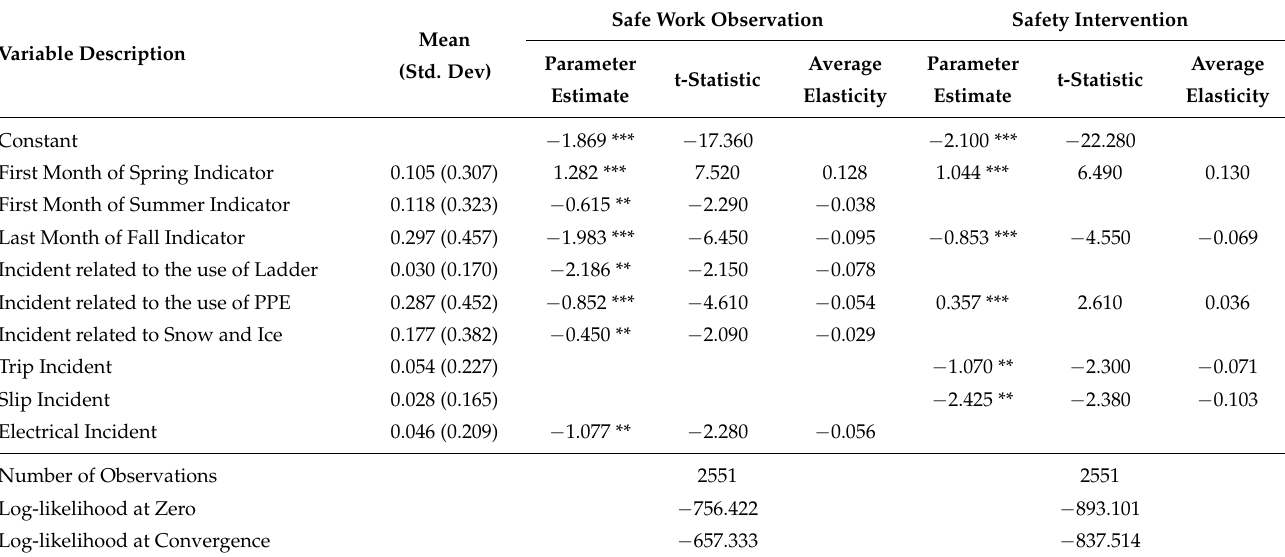
Table 3. Model estimation results and elasticity estimates for safe work observation and safety intervention.